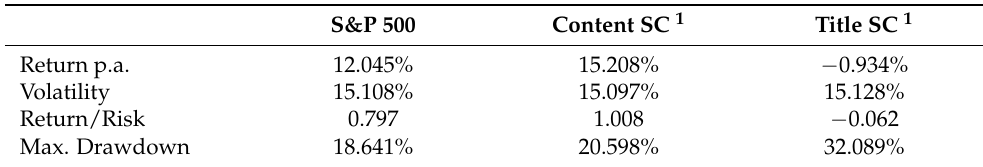
Table 7. Performance measures of strategies based on sentiment scores from 1 January 2011 to 16 August